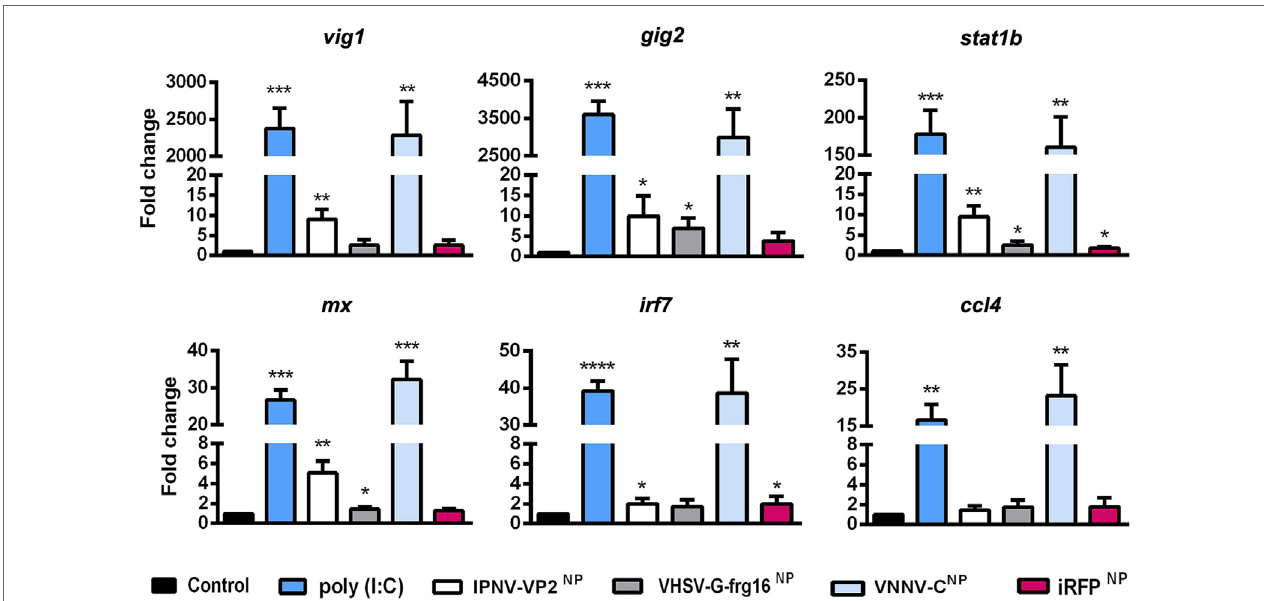
FigUre 3 | Gene expression analysis in ZFL stimulated with nanopellets (NPs). Cells were incubated for 14 h as follows: unstimulated control cells (black), poly(I:C) 25 µg/ml as a positive control (blue), IPNV-VP2 NP 10 µg/ml (white), VHSV-G-frg16 NP 5 µg/ml (gray), VNNV-C NP 10 μ g/ml (light blue), and iRFP NP 10 µg/ml as an immunogenically irrelevant NP control (red). Samples are from two independent experiments. Data are mean ± SD ( n = 4). Gene expression was determined by quantitative real-time PCR with three technical replicates. Differences between each treatment mean and control were analyzed by unpaired one-sided t -tests with Welch’s correction for unequal variances. Significance levels * p < 0.05; ** p < 0.01; *** p < 0.001; **** p <